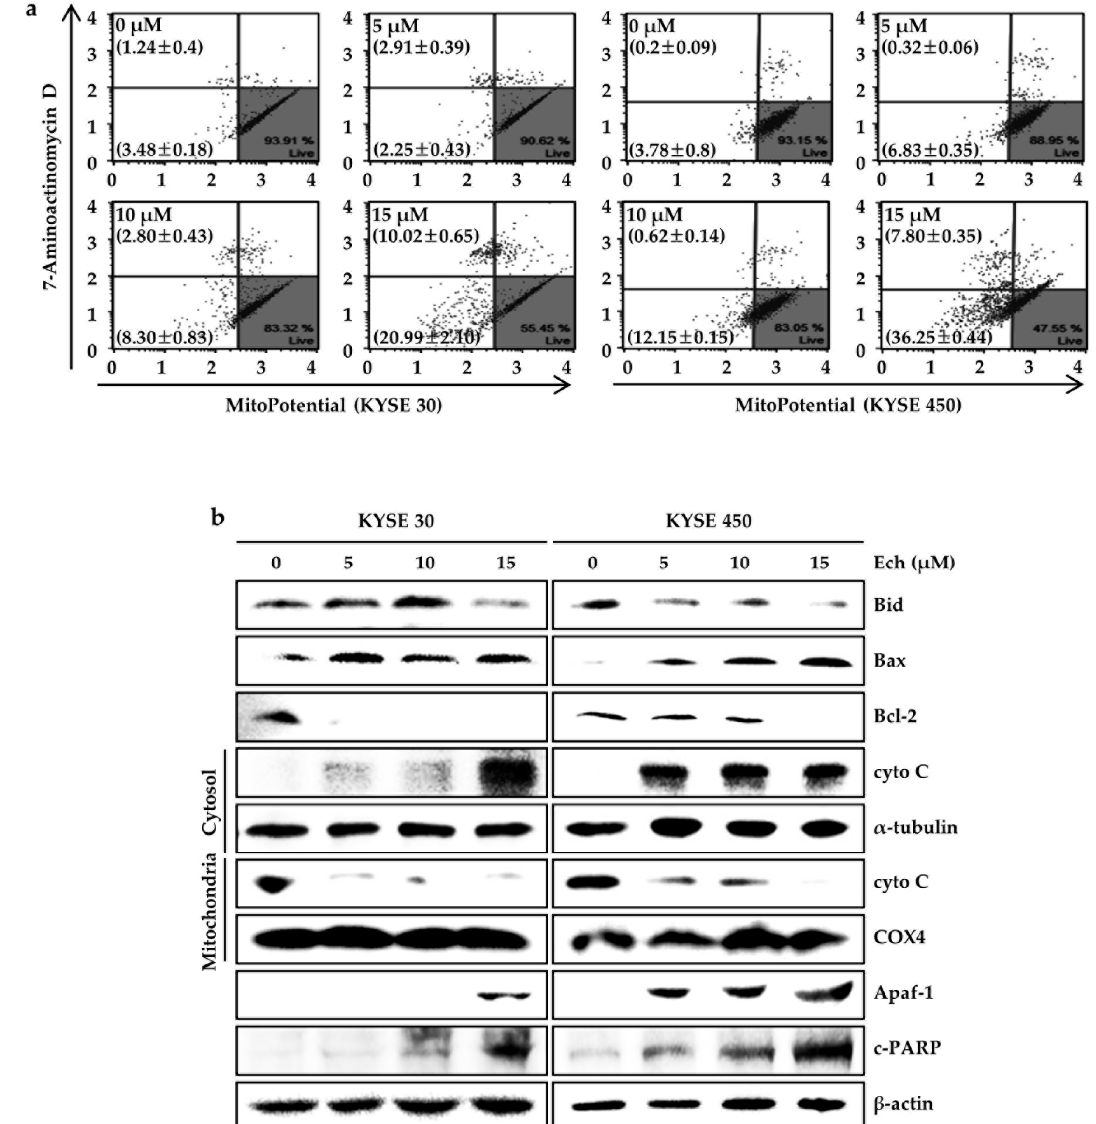
Figure 5. Effect of Ech on MMP activities and apoptosis-related proteins. ( a ) Ech induced MMP dysfunction. Cells were treated with Ech (0, 5, 10, or 15 µM) for 48 h, stained with MitoPotential Dye and 7-AAD, and analyzed with a Muse™ Cell Analyzer. Percentages in the left top show depolarized / dead cells. Percentages in the left bottom show depolarized / live cells. Experiments were done at least three times in triplicate. Data are presented as means ± SD. ( b ) Ech decreased Bid, Bcl-2, and cyto C (mitochondria) expression but increased Bax, cyto C (cytosol), Apaf-1, and c-PARP expression. Western blotting was performed to determine expression levels. β -actin, α -tubulin (cytosol), and COX4 (mitochondria) were used as loading controls.